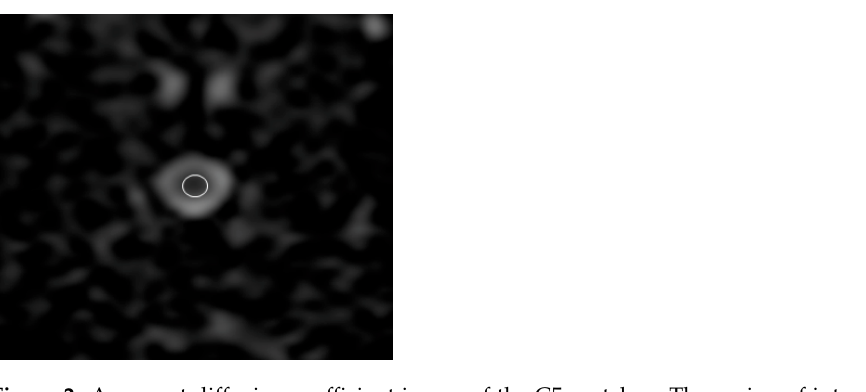
Table 1. Diffusion tensor imaging parameters at each vertebral level.